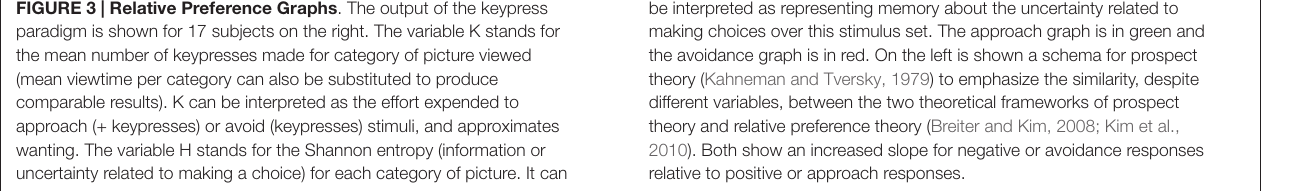
FIGURE 3 | Relative Preference Graphs . The output of the keypress paradigm is shown for 17 subjects on the right. The variable K stands for the mean number of keypresses made for category of picture viewed (mean viewtime per category can also be substituted to produce comparable results). K can be interpreted as the effort expended to approach (+ keypresses) or avoid (keypresses) stimuli, and approximates wanting. The variable H stands for the Shannon entropy (information or uncertainty related to making a choice) for each category of picture. It can